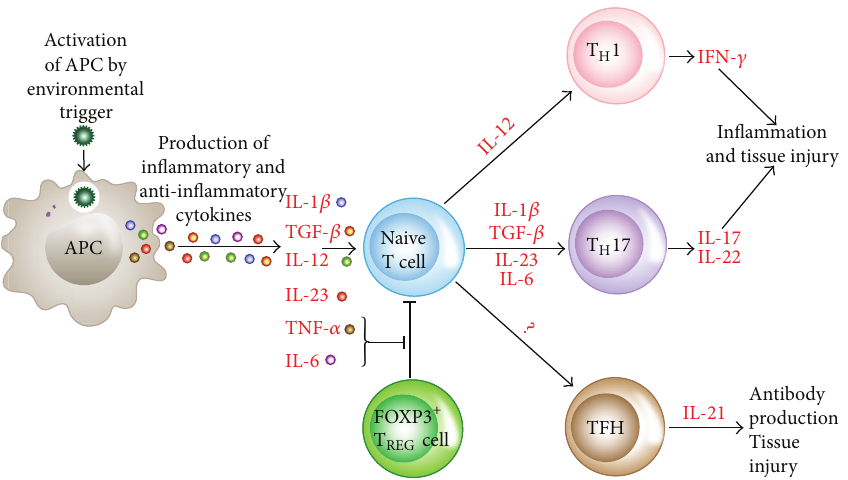
Figure 2: Differentiation of na¨ıve T cells into pathogenic effector T cells. APCs can be activated by numerous factors, resulting in the release of cytokines that promote the differentiation of na¨ıve T cells into various subsets of pathogenic effector T cells that drive inflammation, tissue injury, and autoantibody production. Segmented filamentous bacteria (SFB) can also promote the development of Th17 cells and autoimmune responses in vivo . Proinflammatory cytokines derived from both innate and adaptive immune cells attenuate T REG cell-mediated suppression of effector T cells.